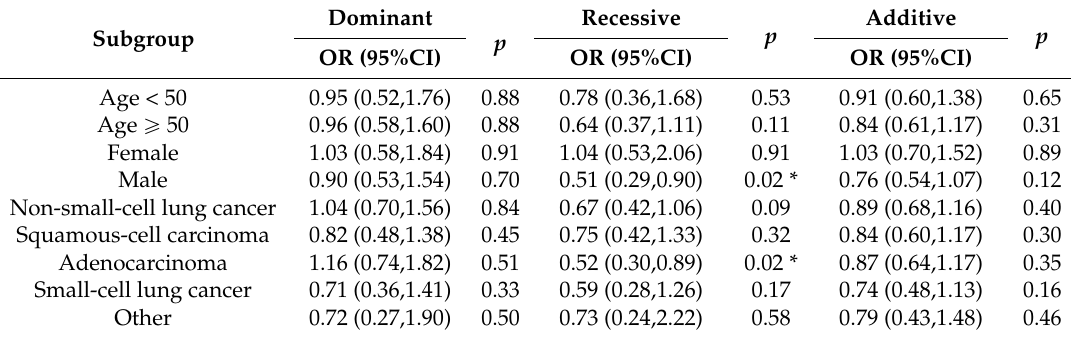
Table 4. Stratification analysis of the relationship between CASC8 rs10505477 and lung cancer